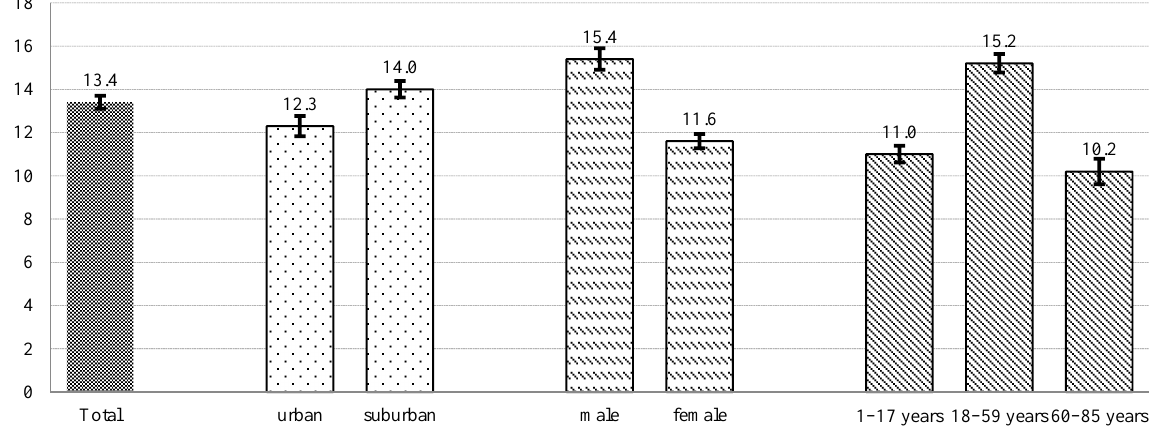
Figure 1. Dietary salt intake by region, gender and age groups (mean, g/person/day).